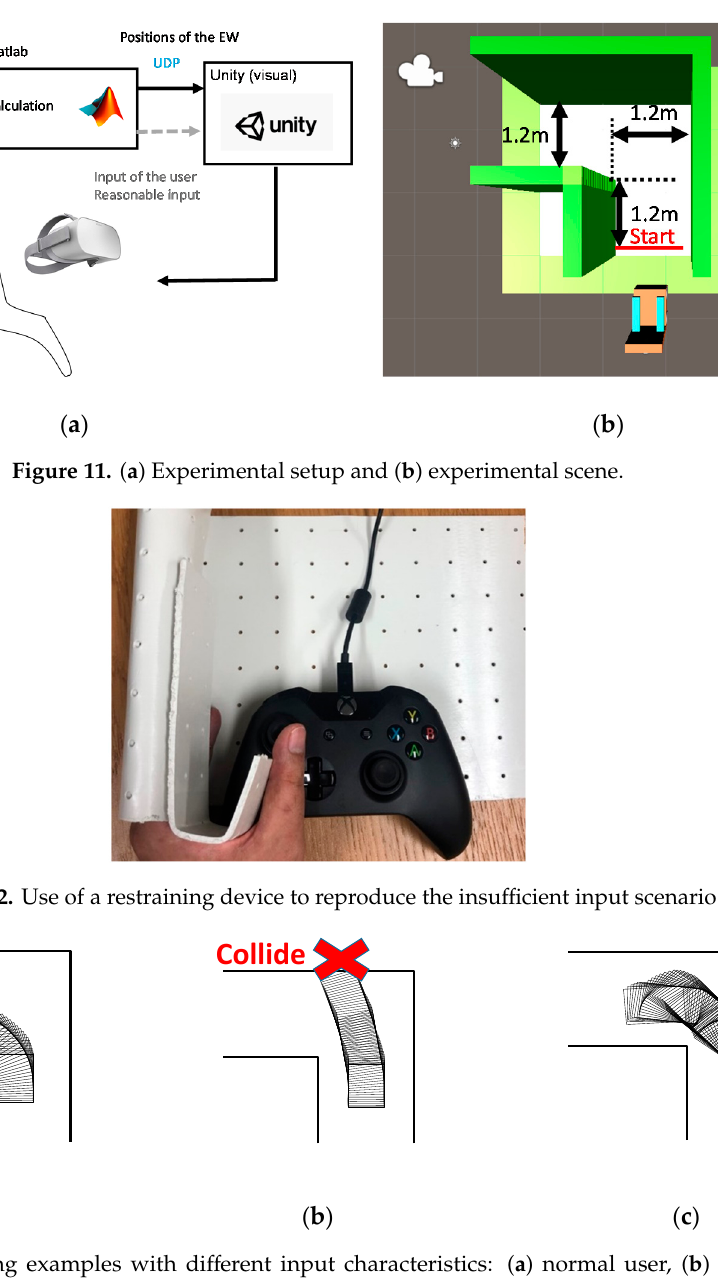
Figure 13. Driving examples with different input characteristics: ( a ) normal user, ( b ) user with